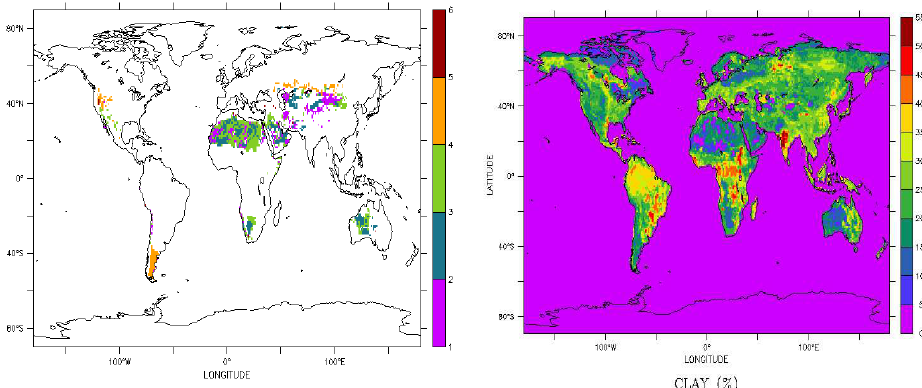
Fig. 1. Left plot: Olson global ecosystem biomes. The indices on the colour bar correspond to the values in Table 2. Right plot: clay content of the soil (%). Both plots at 1 ◦ × 1 ◦